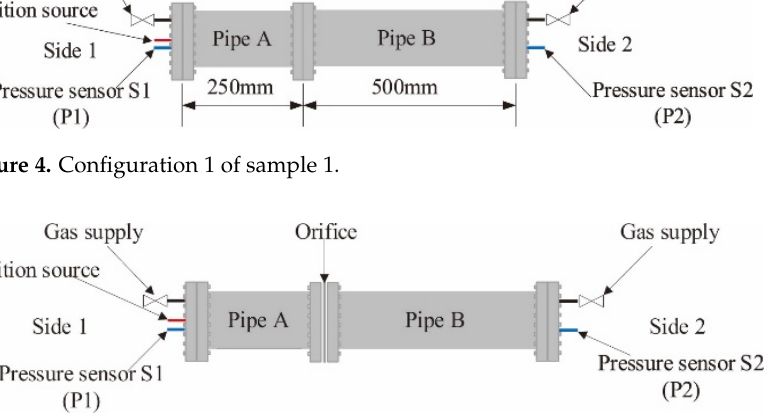
Figure 5. Configuration 2 of sample 1. Table 1. Experimental condition for Sample 1.